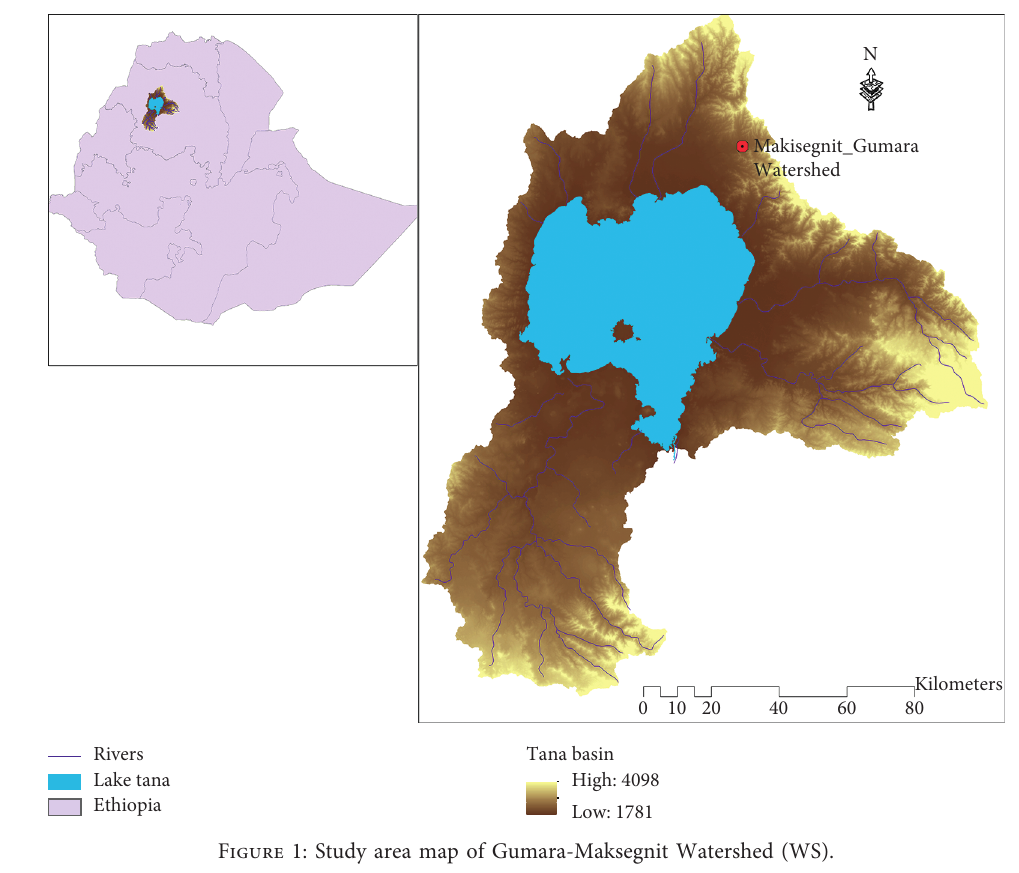
Figure 1: Study area map of Gumara-Maksegnit Watershed (WS).